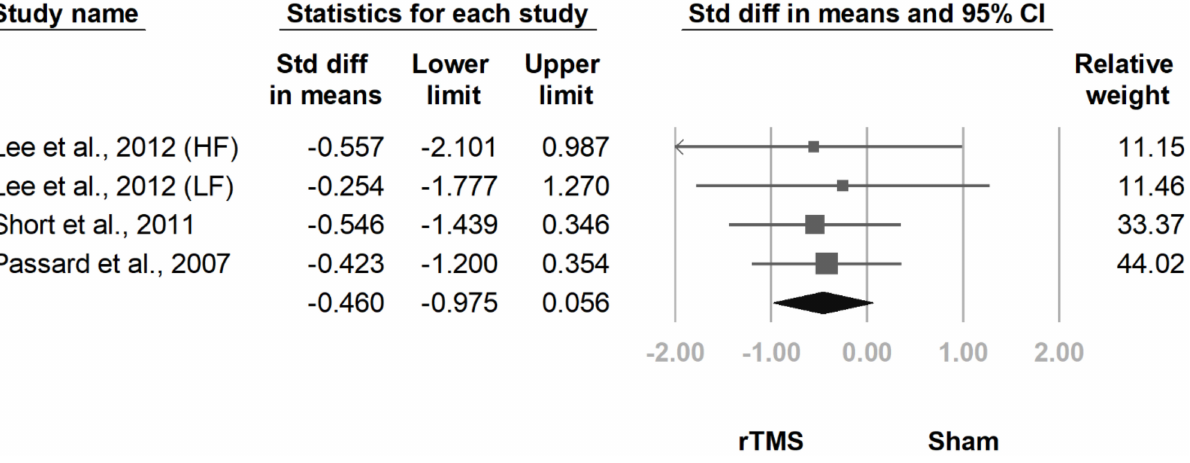
Figure 14. Forest plot of standardized mean differences in number of tender points at follow-up at 2 weeks to 1 month after last treatment session. Squares indicate effect sizes of individual studies, lines indicate 95% CI, and diamond indicates the summarized effect